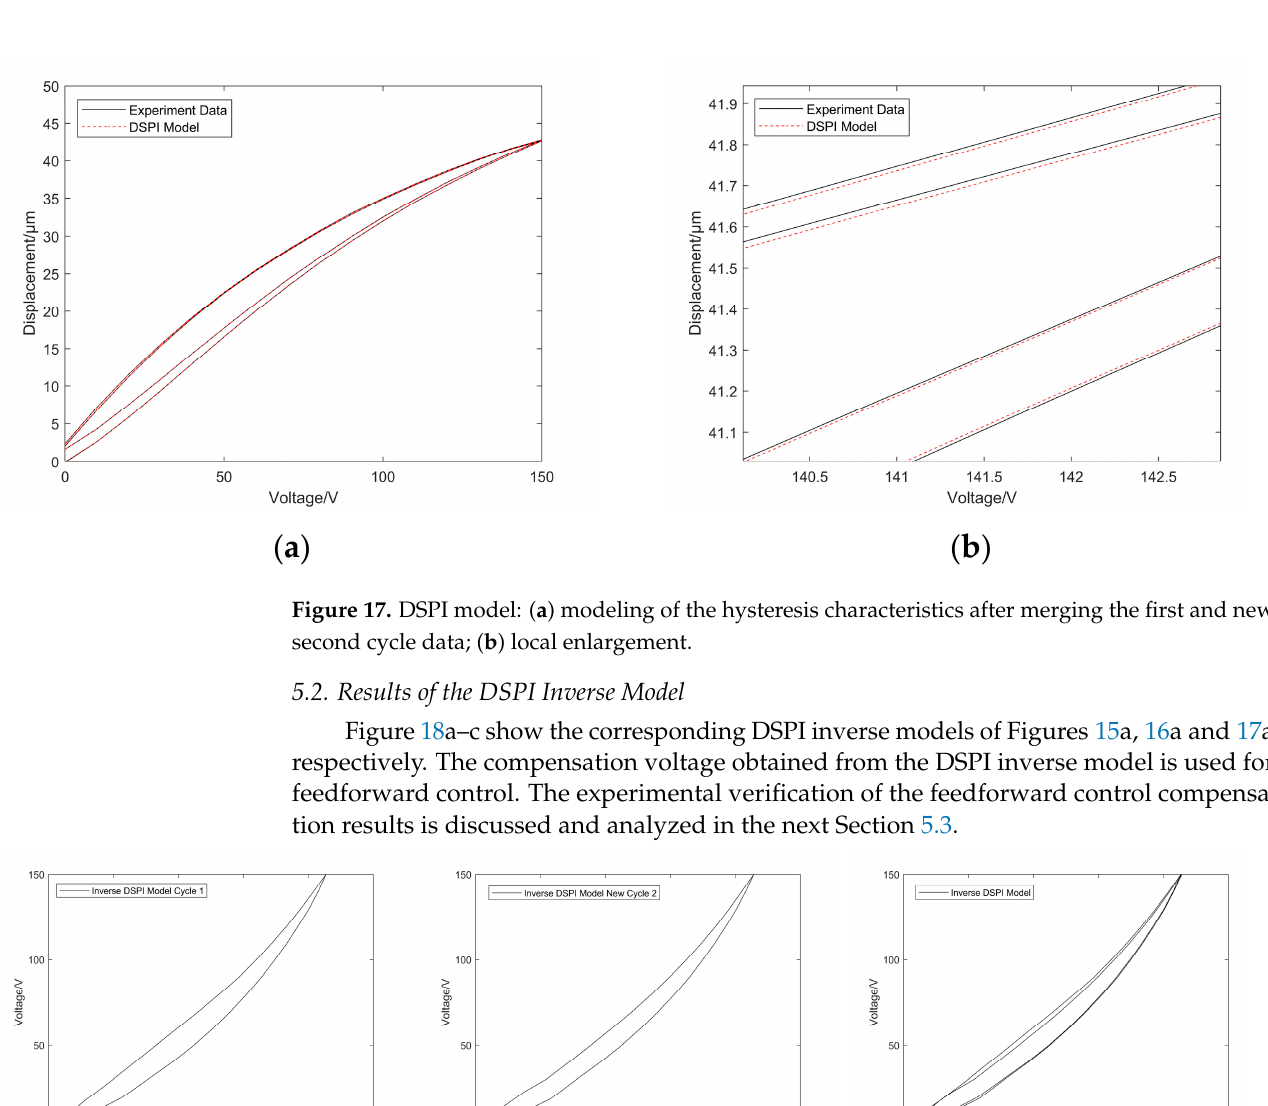
( b ) Figure 16. DSPI model: ( a ) modeling of the new second cycle data hysteresis characteristics; ( b ) local enlargement. As shown in Figure 17, the hysteresis characteristics are modeled after combining the